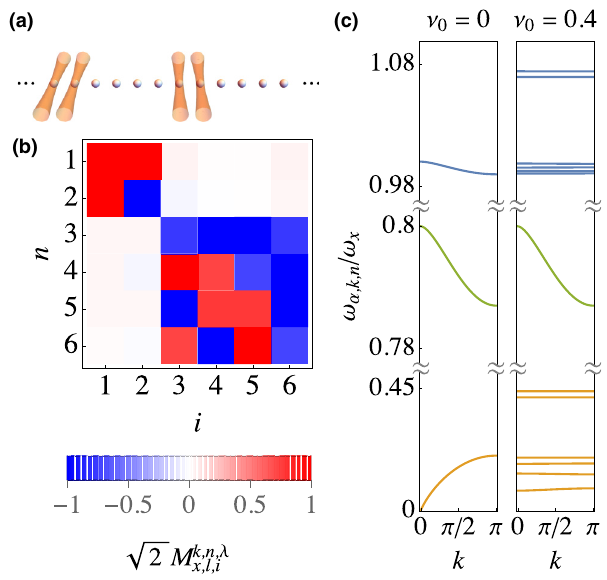
FIG. 3. (a) Infinite ion chain with optical tweezers forming a periodic array with unit cell size p = 6. (b) Mode matrix M k , n , λ for l = k = 0 and λ = 1. COM and stretch modes of the pinned ions are clearly decoupled from the ions that are not pinned. (c) Phonon-mode spectra for an infinite chain without and with opti- cal tweezers, for ν 0 = 0 and ν 0 = 0.4, respectively. Transverse x and y modes and longitudinal z modes are shown, respectively, in blue, green, and orange. The spatial periodicity imposed